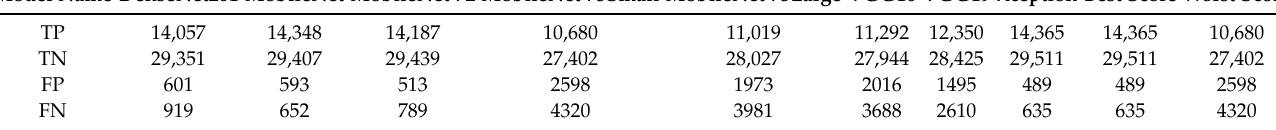
Table 6. The confusion matrix (i.e., TP, TN, FP, and FN) for each pretrained CNN model using the “Alzheimer’s Disease Neuroimaging Initiative (ADNI)” dataset.